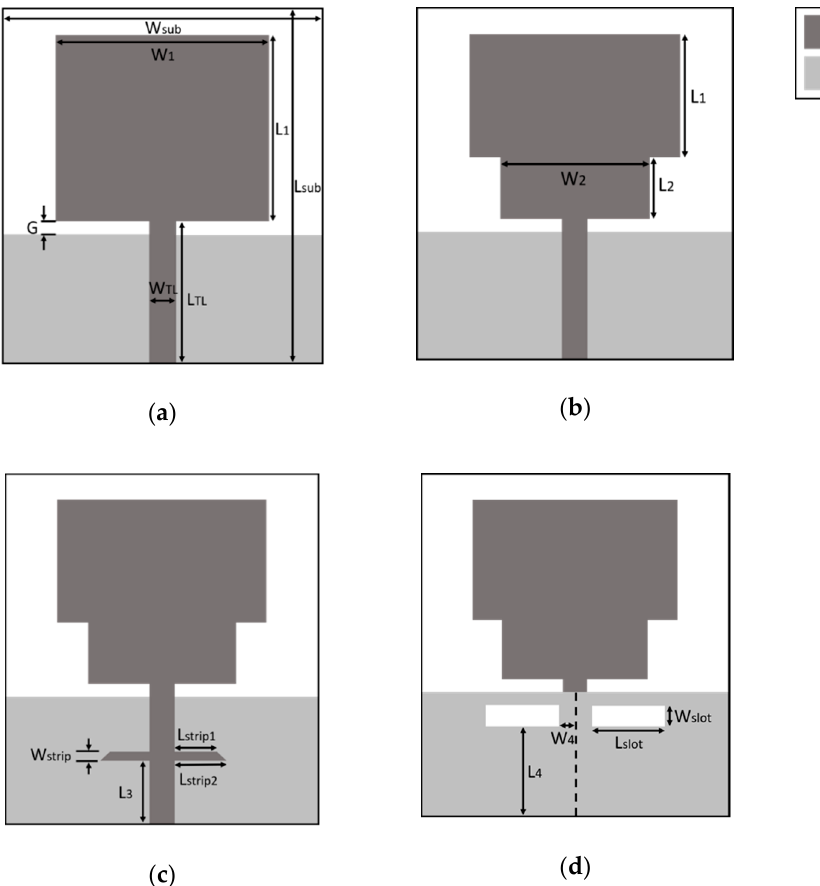
Figure 1. Antenna geometry: ( a ) Printed monopole antenna used as a starting point; ( b ) Antenna with two rectangular steps; ( c ) Antenna with strips; ( d ) Final antenna